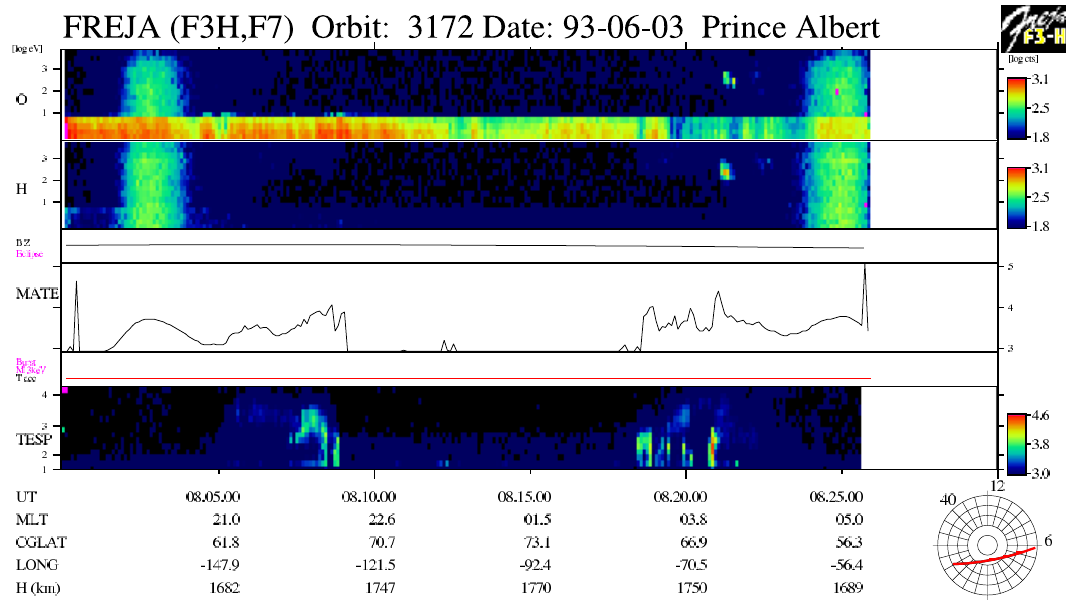
Fig. 1. Example of a Color Summary Plot (CSP) for a high-latitude pass of Freja. The satellite orbit is indicated in the circular coordinate system at the lower right (magnetic local time, MLT, and corrected geomagnetic latitude, CGLAT). The two uppermost frames show the logarithm of the count rate, color-coded as a function of time and the logarithm of the energy of O + and H + ions measured by means of the TICS spectrometer. Frames 3 and 5 may contain some auxiliary data (not used in this investigation) and frames 4 and 6 show electron data from the MATE and TESP instruments, total particle flux in the energy range from a fraction of a keV to about 100keV in the case of MATE and the count rate, color-coded, of the electrons as a function of time and energy from TESP. UT, MLT, CGLAT, LONG (geographic) and altitude, H, are listed at the bottom. A description of the various recorded count rates and what they represent can be found in the text. The data of particular interest in the present investigation are the relatively intense ion count rates seen in a short period of half a minute at about 08:21UT.